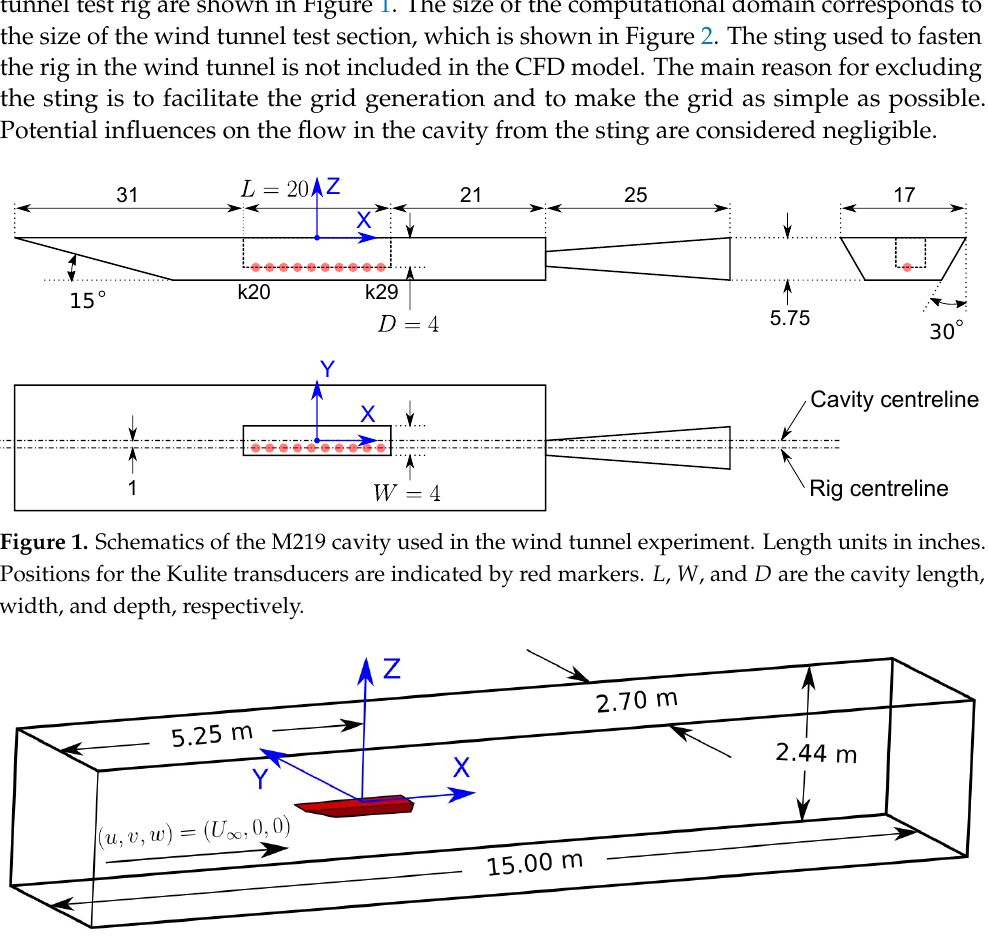
Figure 2. Computational domain for the wind tunnel model.